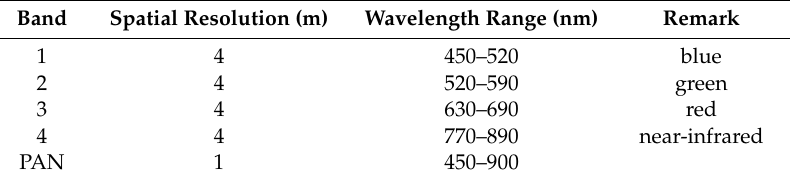
Table 2. Spatial resolution and wavelength range of each band of GaoFen-2 satellite imagery.